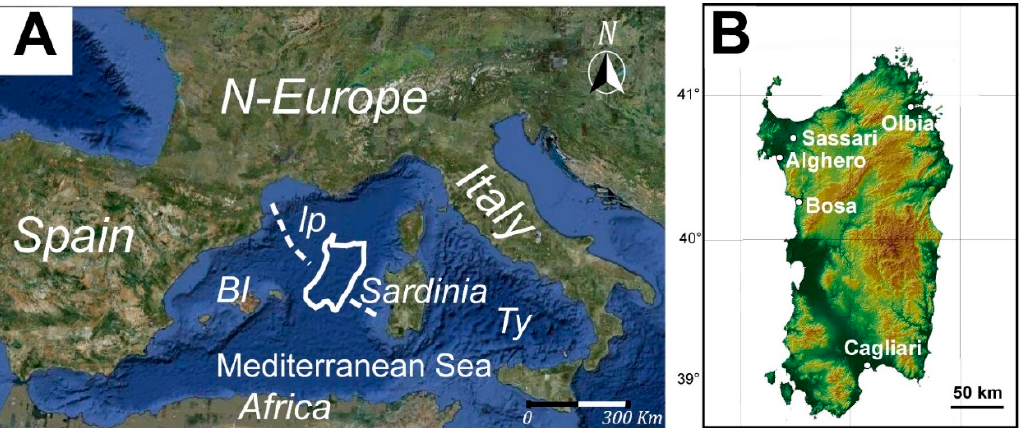
Figure 1. Sardinia. A ) Satellite view of the Mediterranean region where Sardinia occupies a central position. Dashed line indicates the Sardinia anticlockwise rotation of the island occurred that in the Neogene time; B ) Digital terrain model of Sardinia; in the map are reported the main cities. Alghero is on the north-west coast. BI = Balearic Islands; lp = Liguro–Provençal Basin; Ty = Tyrrhenian